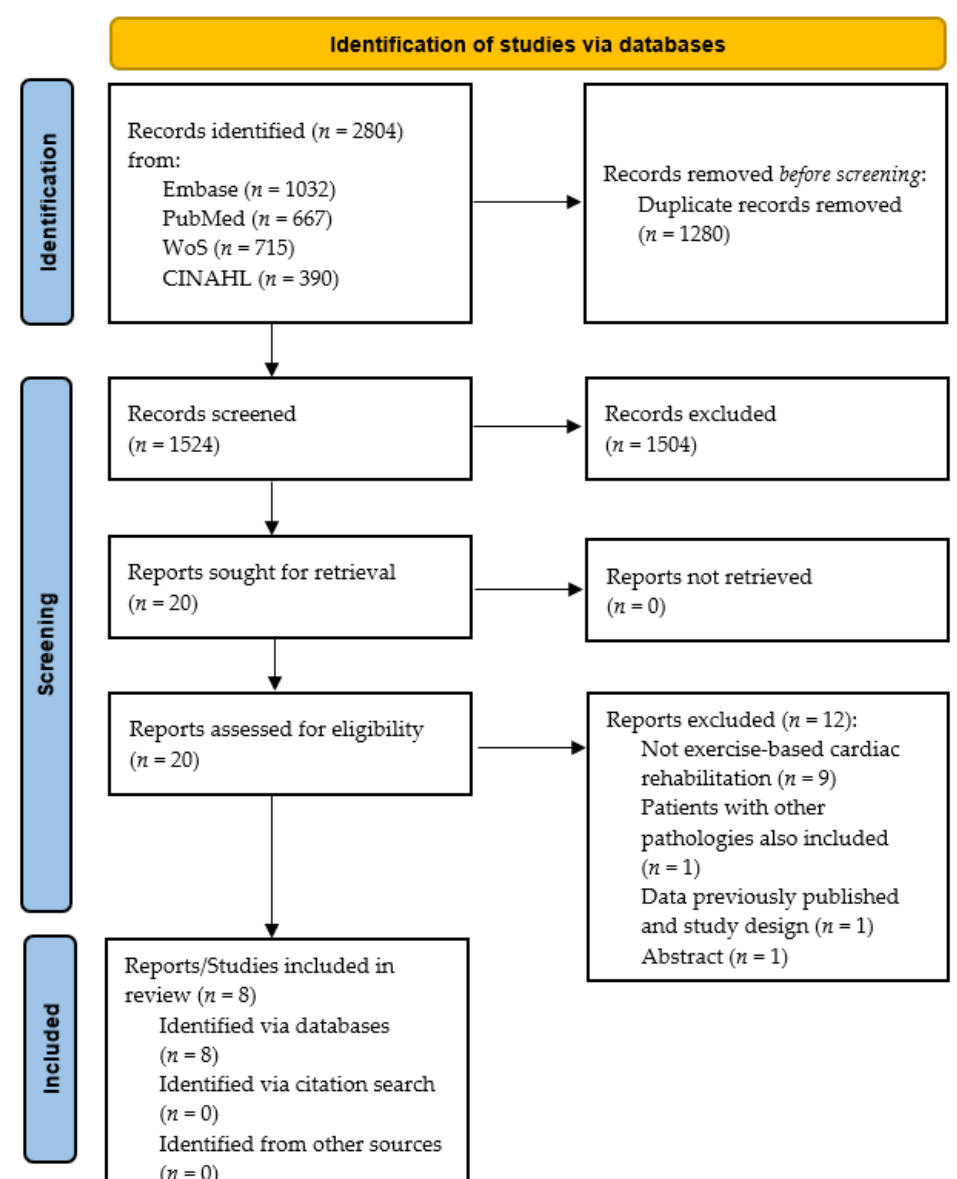
Figure 1. Flow chart of the systematic review process.